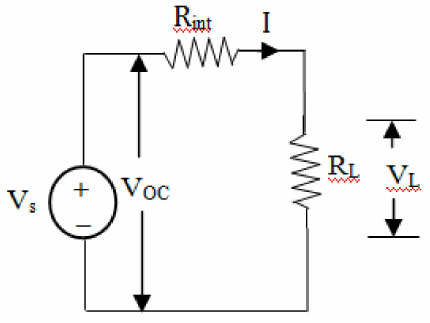
Figure 2. TEG electrical equivalent